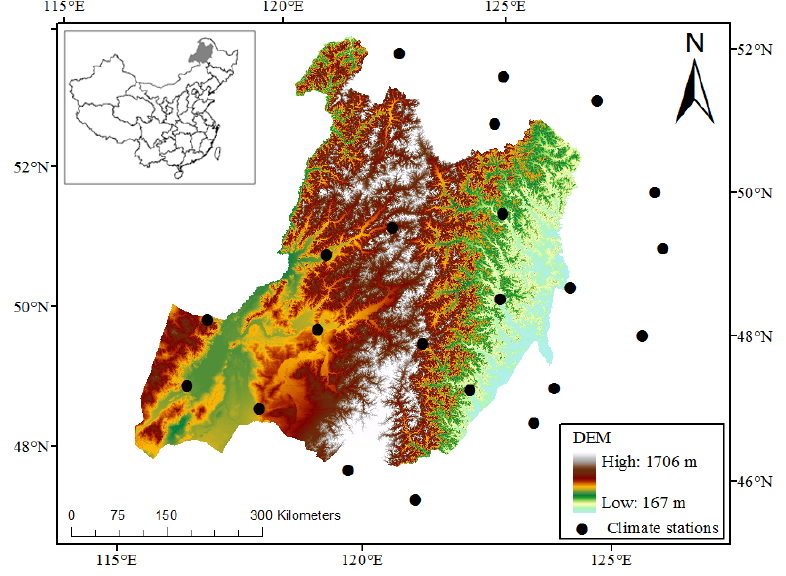
Figure 1. Spatial patterns in the digital elevation model (DEM) of the Hulunber